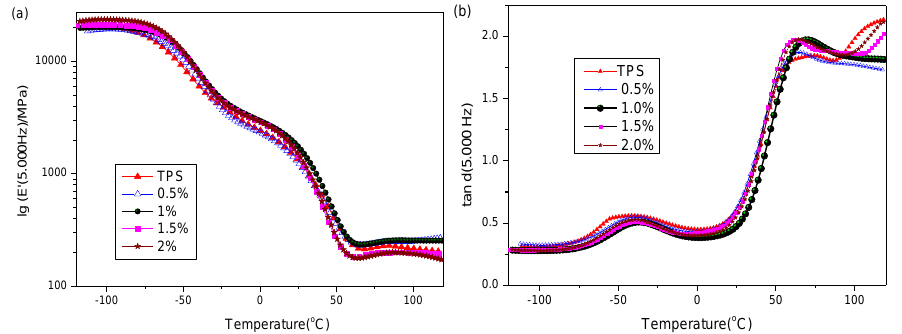
Figure 3. DMA(dynamic mechanical analysis) curves of PVAMS/TPS composites prepared at varying PVAMS content (0–2 wt %). (Frequency: 5 Hz). ( a ) E’ vs. Temp; ( b ) tan δ curve.